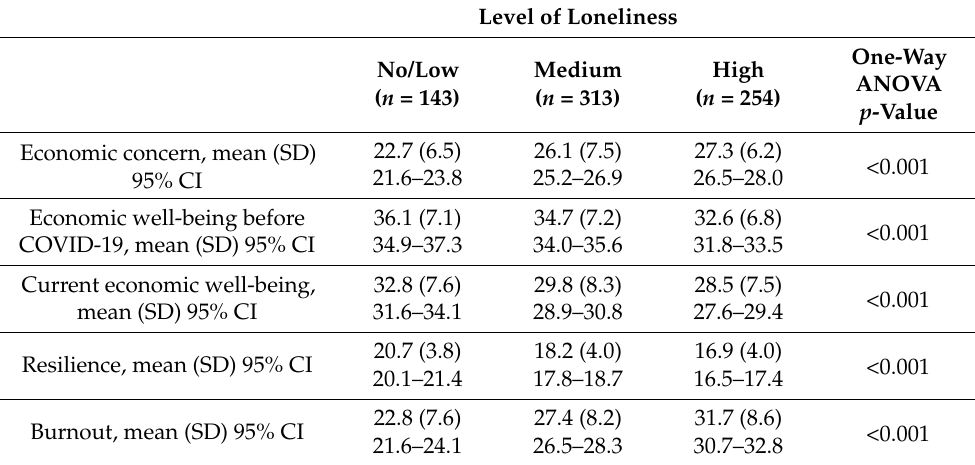
Table 2. Loneliness level by economic conditions, resilience, and